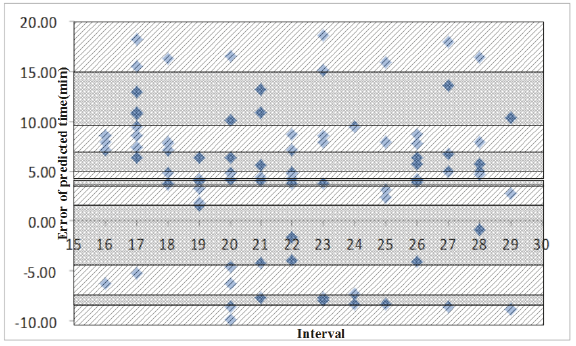
Figure 6: Prediction error distribution of 𝐿 1,2